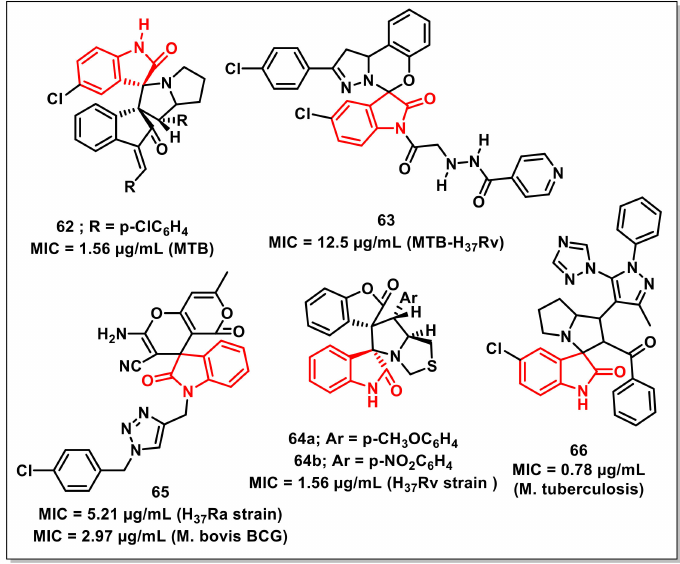
Figure 10. Spiro-isatins as promising